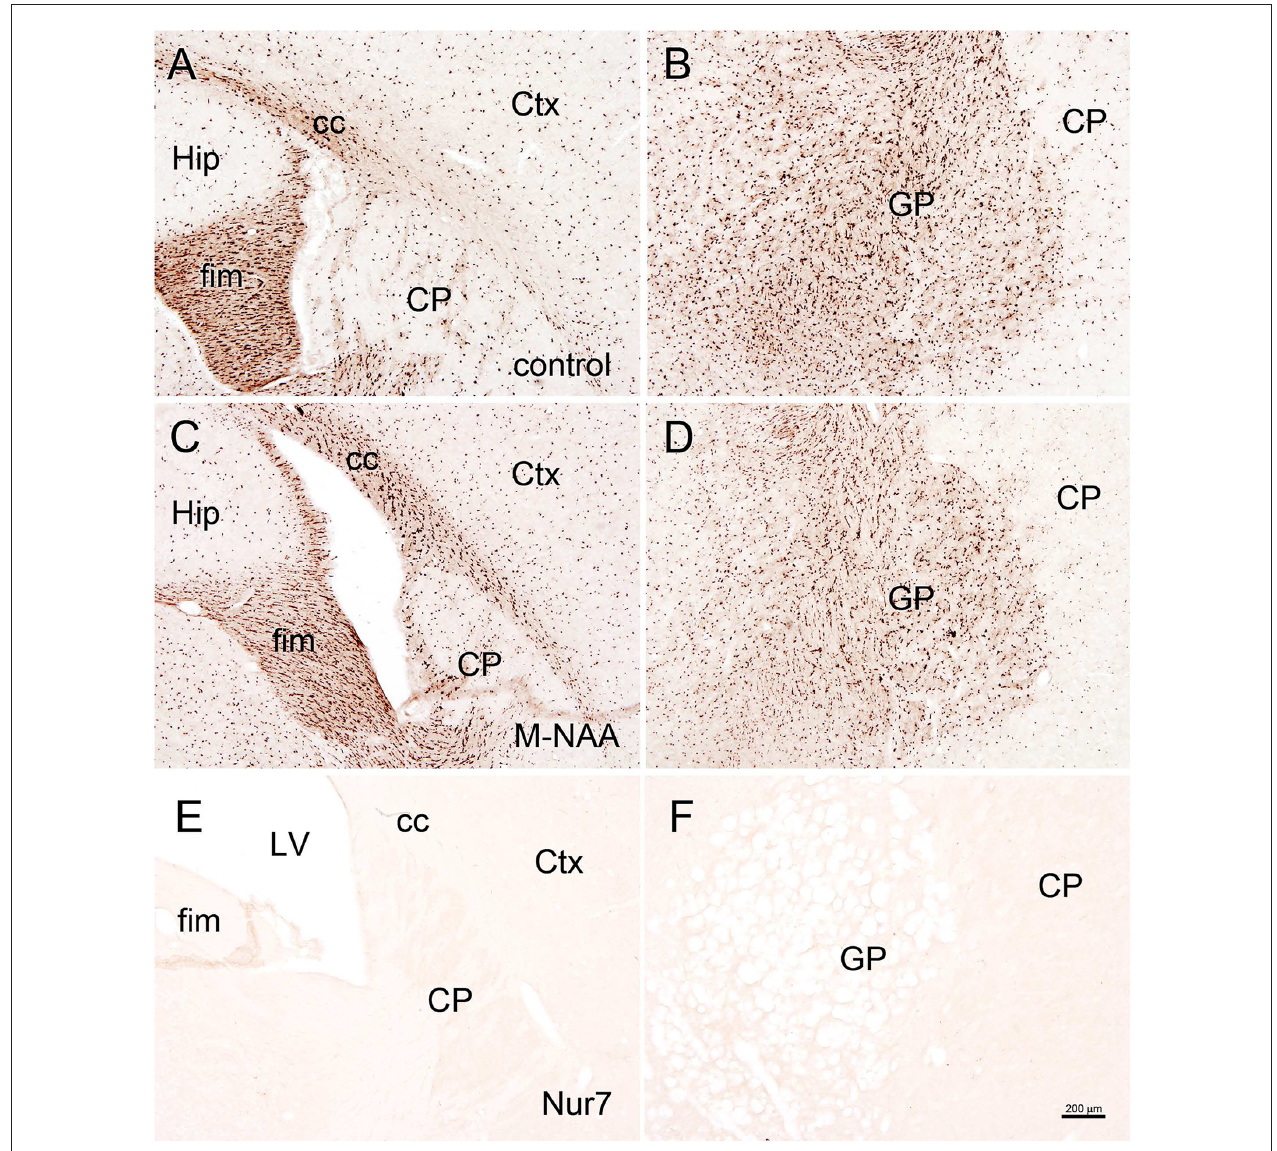
FIGURE 6 | ASPA immunohistochemistry. Aspa immunoreactivity was very strong in oligodendrocytes throughout the brain in untreated wild type mice (A,B) . Minor animal to animal staining variability was observed with antibodies to Aspa, but no consistent changes in immunoreactive intensity were observed after 30 days of treatment with either M-NAA (C,D) or methanol (data not shown) treatment. Aspa immunoreactivity was completely absent in Nur7 mice (E,F) . Abbreviations: cc, corpus callosum; CP, caudate-putamen; Ctx, cortex; GP, globus pallidus; fim, fimbria; Hip, hippocampus; LV, lateral ventricle. Micron bar = 200 µ